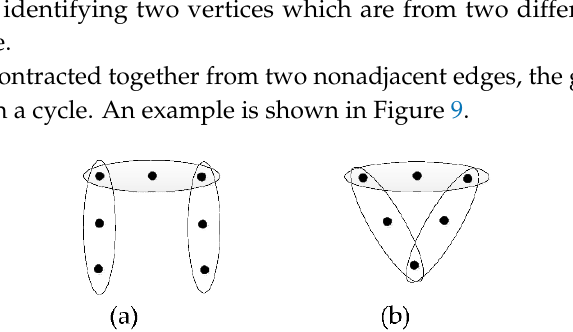
Figure 9. The linear variation (shown as ( b )) is from the 3 ‐ uniform GHT (shown as ( a )), and the number of vertices of ( b ) is 1 less than that of ( a ).